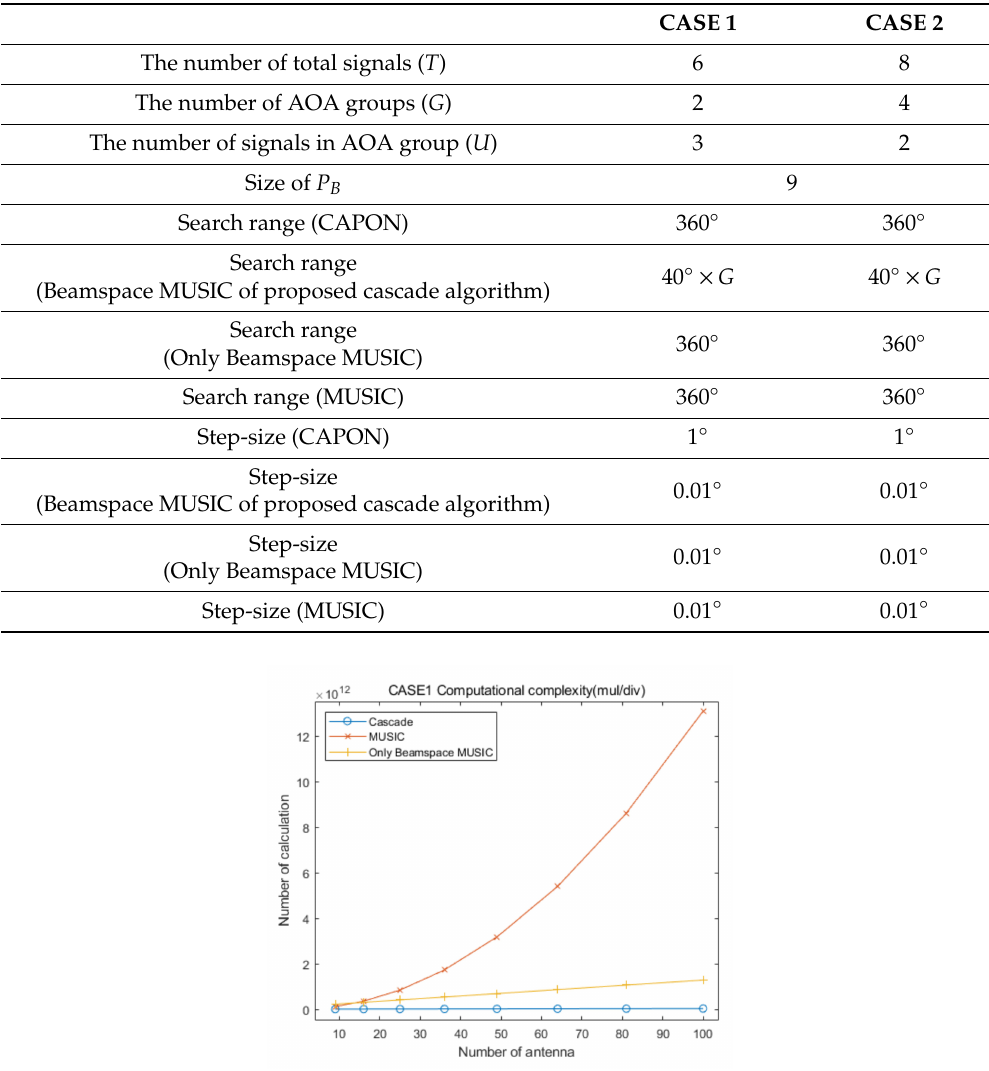
Table 7. Scenario for comparing computational complexities of the proposed cascade algorithm, the general MUSIC algorithm, and the only Beamspace MUSIC algorithm.